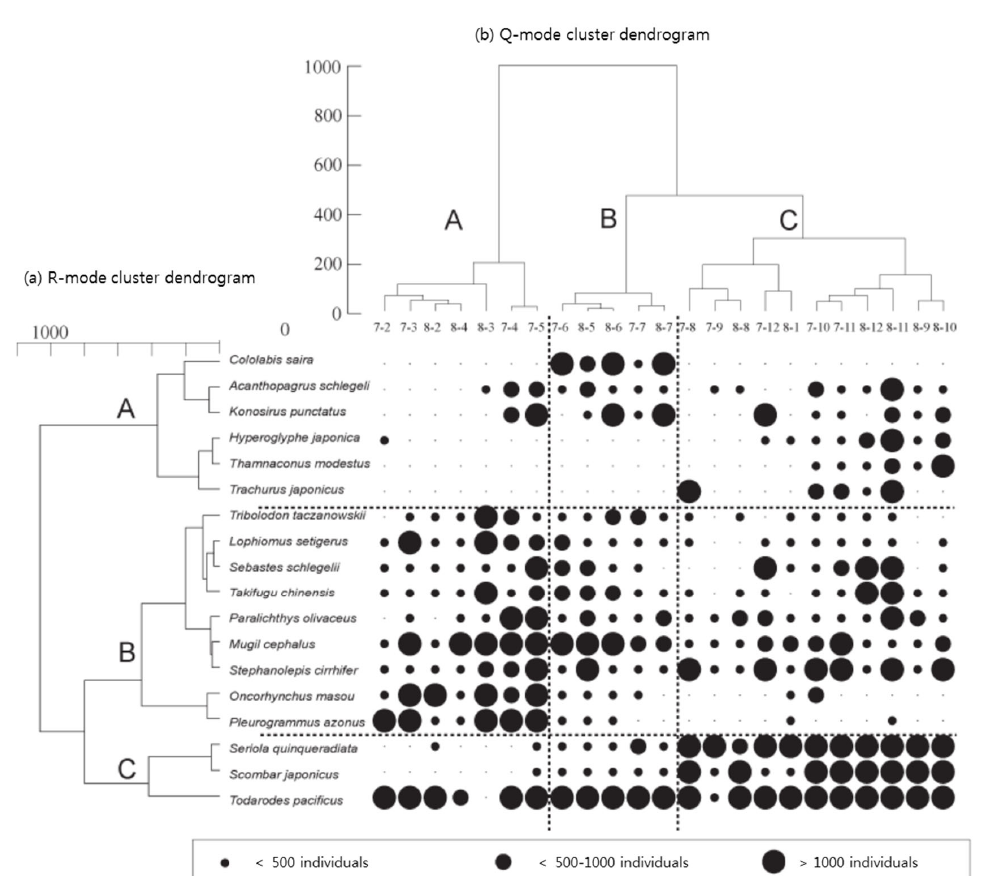
Figure 5. Cluster dendrograms based on the cluster analysis and relative abundance of the 18 most dominant fish species from 2007 to December 2008. ( a ) R ‐ mode cluster dendrogram and ( b ) and Q ‐ mode dendrogram. Monthly expressions are simplified in the form as 7–2 (February 2007).